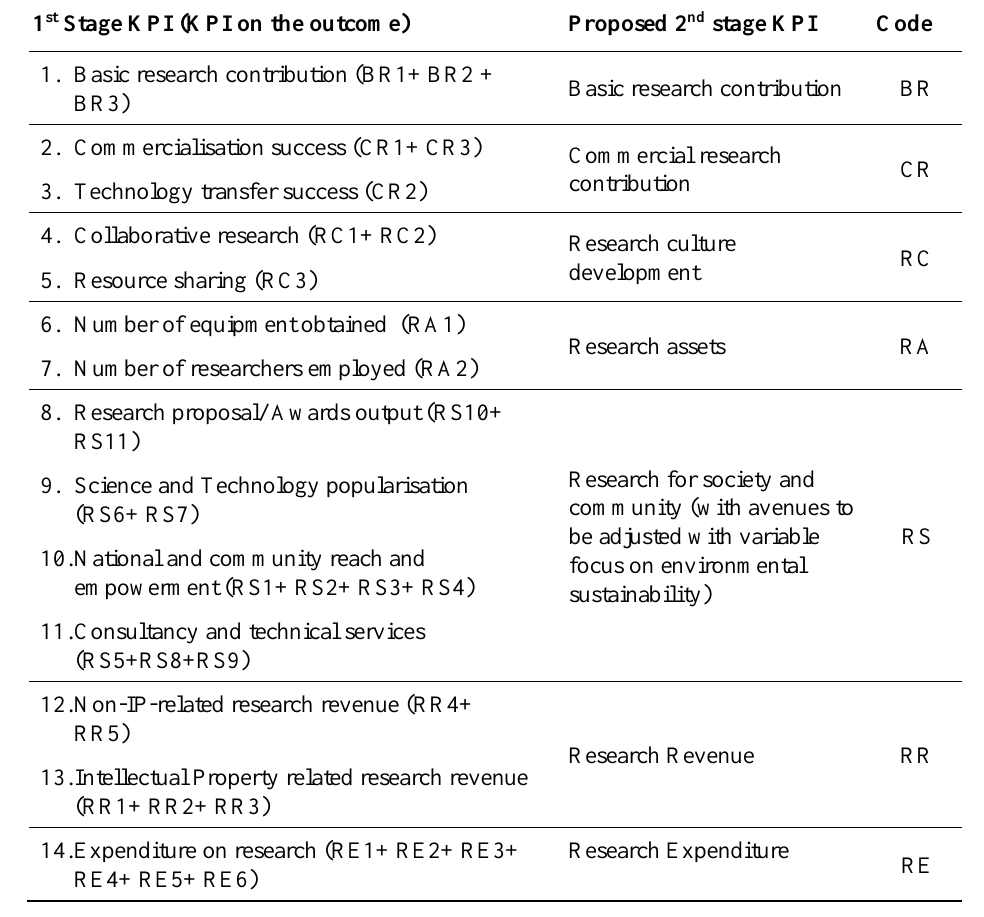
Table 3: First Stage KPI Statements Classified under the Criteria and Proposed Second Stage